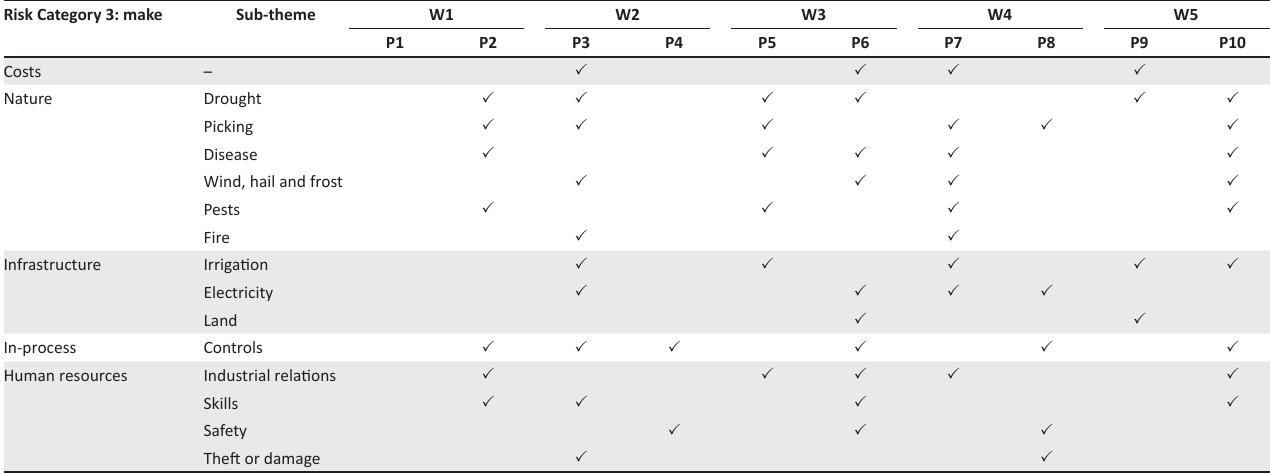
TABLE 4 : Make risks identified by participants. Risk Category 3: